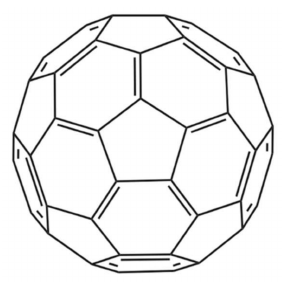
Figure 4. Chemical structure of the C60 fullerene [45].